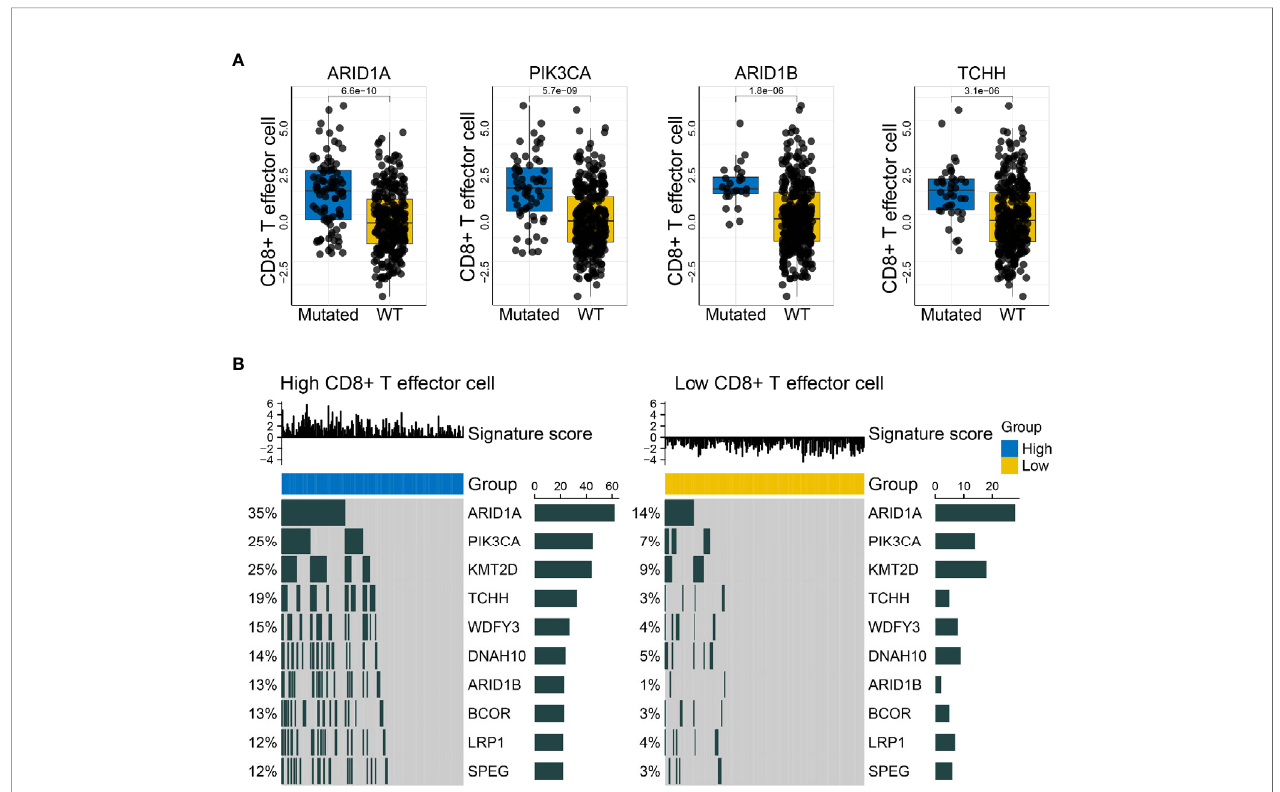
FIGURE 4 | IOBR delineates the mutations correlated with the CD8 + T effector signature and the corresponding oncoplot. (A) Boxplots displayed the mutations signi fi cantly associated with CD8 + T effector signature expression, comprising PIK3CA , ARID1A , ARID1B , and TCHH ( p = 5.7 × 10 − 09 , 6.6 × 10 − 10 , 1.8 × 10 − 06 , and 3.1 × 10 − 06 , respectively). The blue and yellow colors represent mutated and wild-type statuses. Each dot displays a patient within the IMvigor210 cohort in pertinent subgroups. (B) Oncoprints depicted the genomic alteration landscapes in the context of high- and low- CD8 + T effector signature score. The upregulation of ARID1A , PIK3CA , KMT2D , TCHH , WDFY3 , DNAH10 , ARIDB1 , BCOR , LRP1 , and SPEG were observed in the high CD8 + T effector expression setting. The numbers on the left green bars and on the right side collectively demonstrated the mutation frequency of each